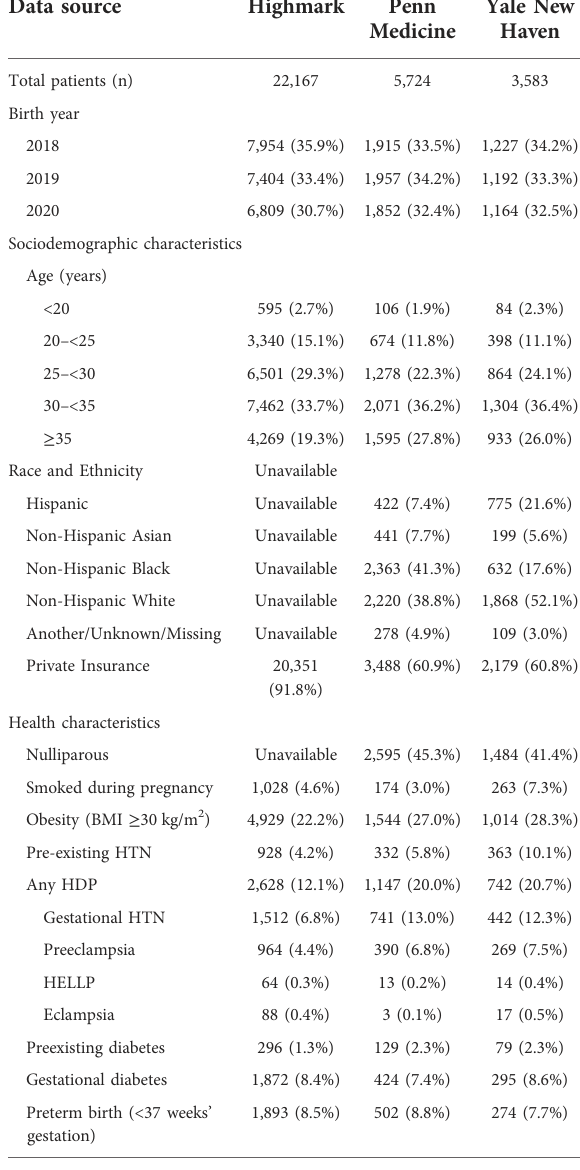
TABLE 1 Patient characteristics in each of the three data